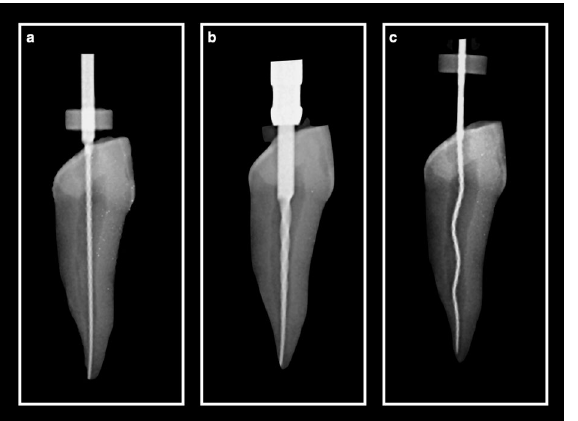
Figure 2. Radiographic image of the three files in a primary canine (mesio-distal projections) ( a ) #30 hand K-file, ( b ) Kedo-S E1 rotary file, and ( c ) XP-endo